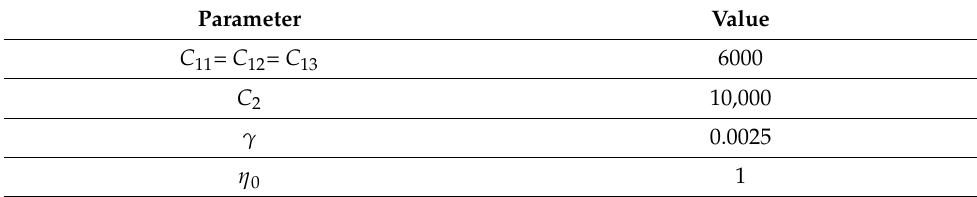
Table 3. The design control parameters.